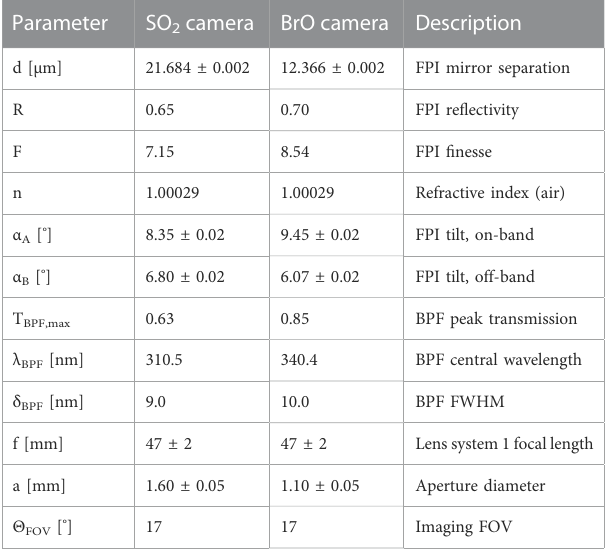
TABLE 1 Instrumental and optical parameters of both camera systems with uncertainties. Parameter SO 2